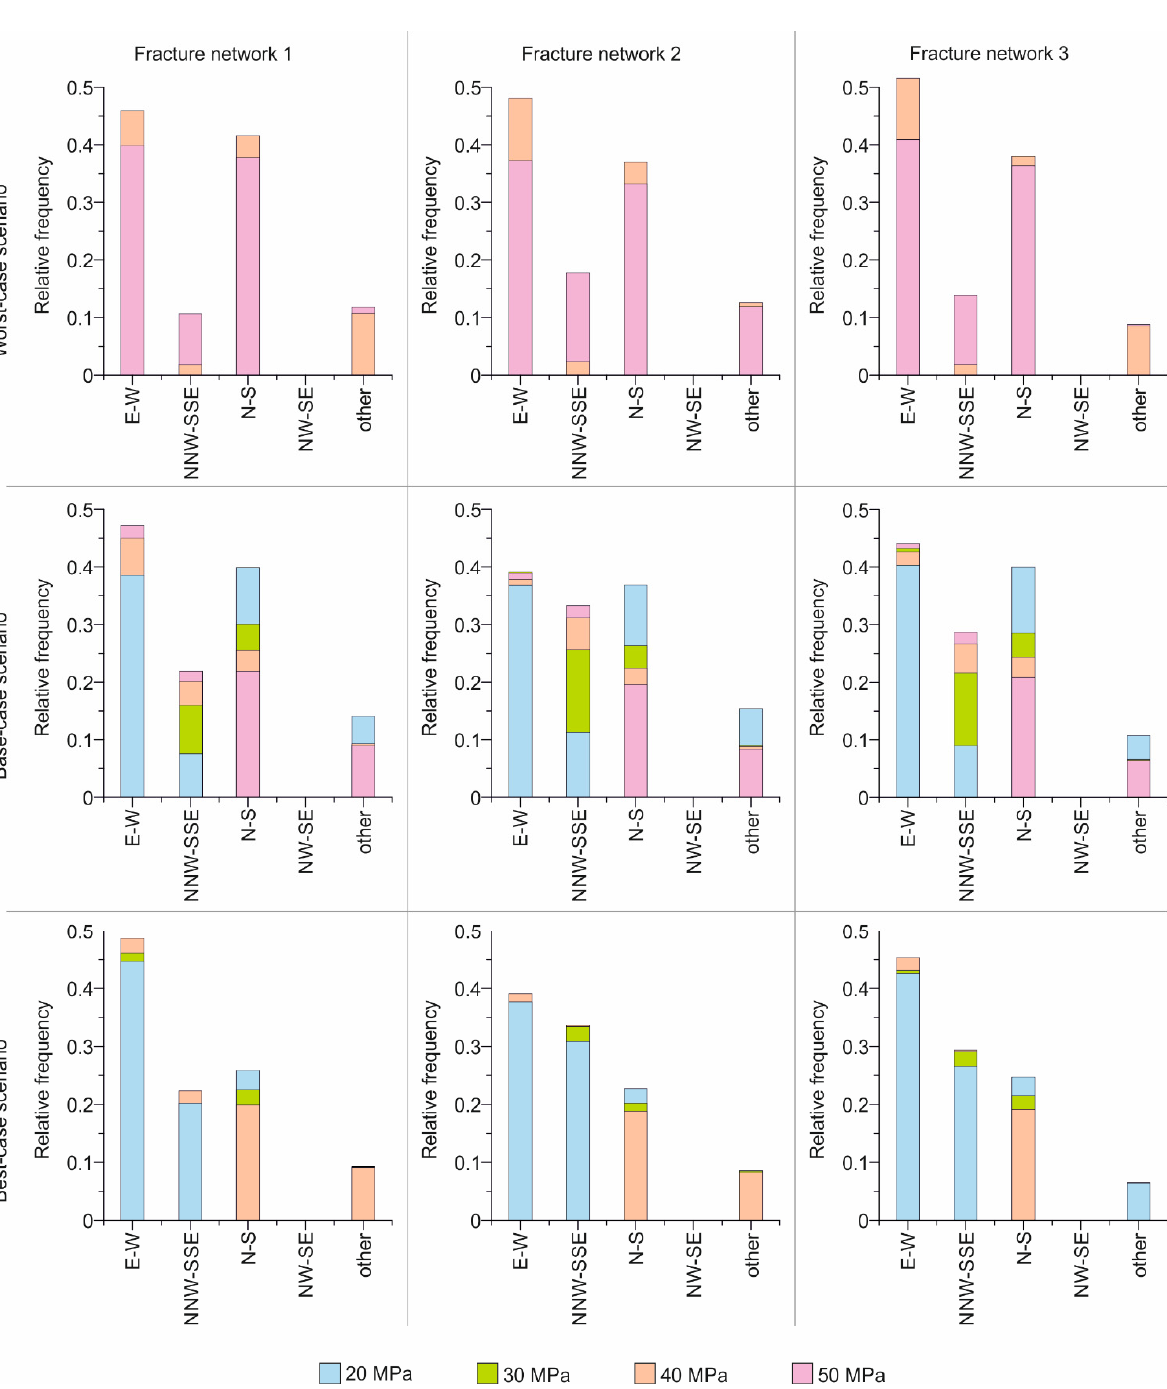
Figure 10. Sheared fractures grouped by sets for different stimulation fluid pressure. The reader is referred to Section 4.2 for further details on the fracture network and to Table 1 for further information on the properties of the medium. Relative frequency, in this context, corresponds to the percentage of fractures that slipped in each set from the total of fractures that slip.